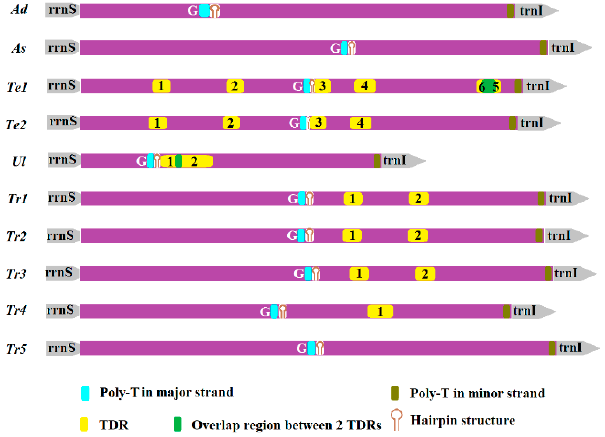
Figure 6. Organization of the AT-rich region in ten Tenebrionidae mitogenomes. Tandem repeats (TDRs) refers to tandem repeats.